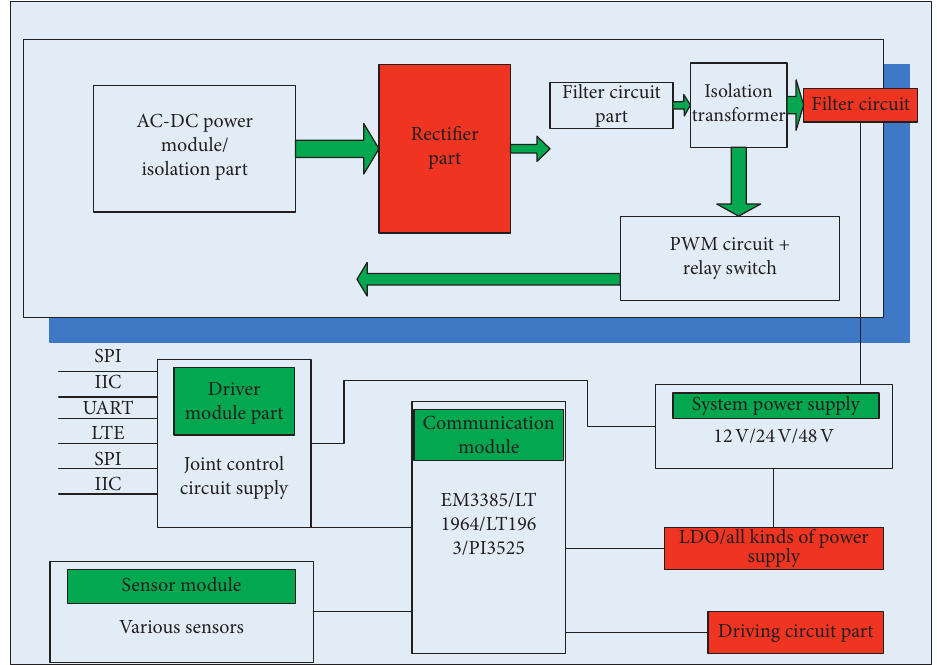
Figure 5: Power module block diagram of wearable intelligent